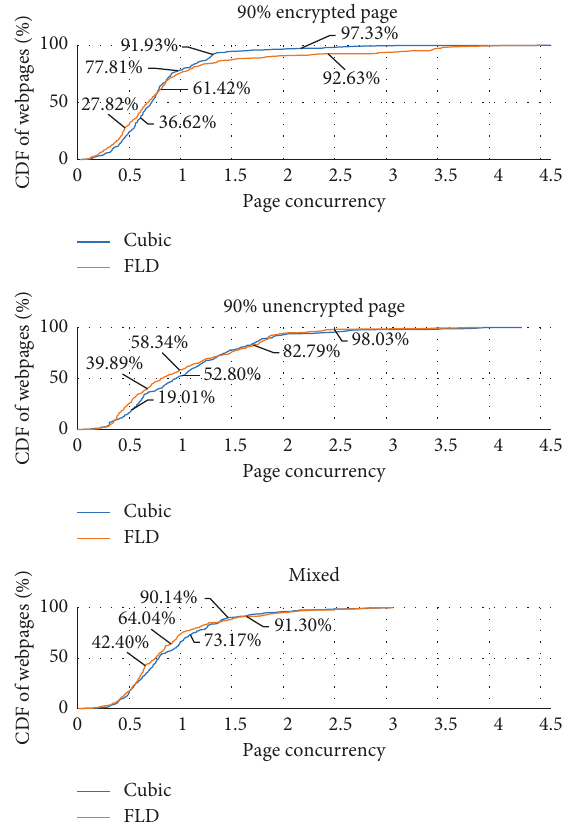
Figure 8: Effective connection concurrency across pages for dif- ferent page types.